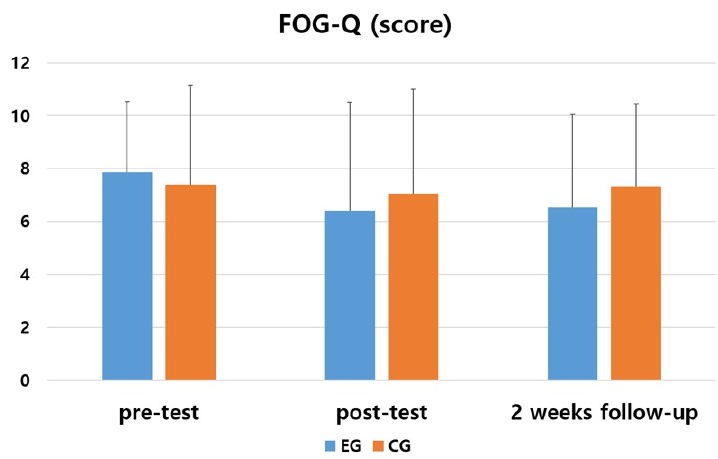
Figure 4. Comparison of the changes of within and between groups in